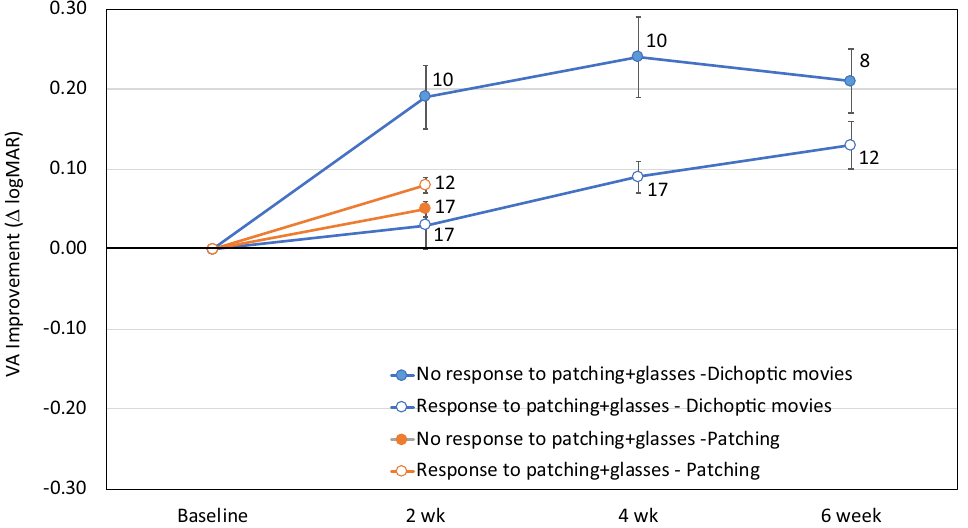
Figure 3. Visual acuity improvement in the movie and patching groups in children who had a clinical history of prior visual acuity improvement when treated with glasses and patching and children who had no visual acuity improvement when treated with glasses and patching. Numbers to the right of each data point indicate the n at each timepoint for each subgroup. Note that 3 children in the movie group and 1 child in the patching group were too young to provide visual acuity data on two visits prior to the enrollment visit and, as a result, could not be categorized as no response or response. These children were excluded from this